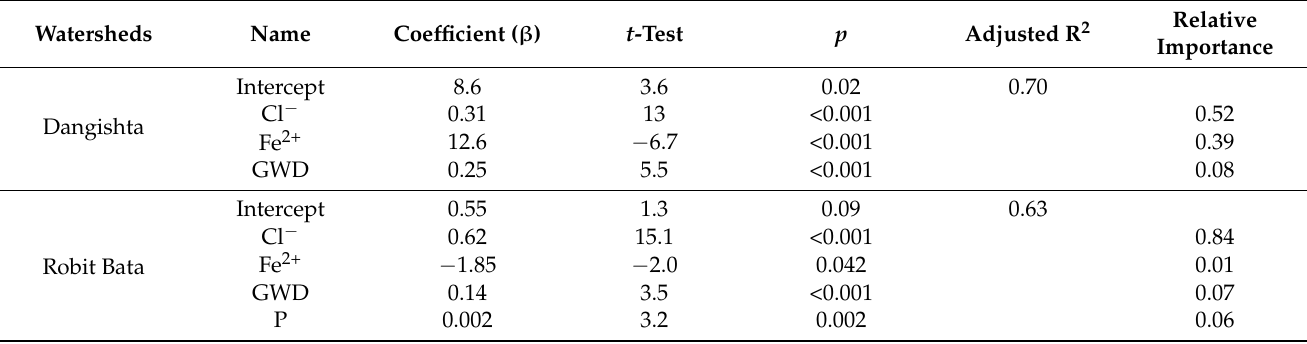
Table 4. Coefficient of the regression equations to estimate nitrate